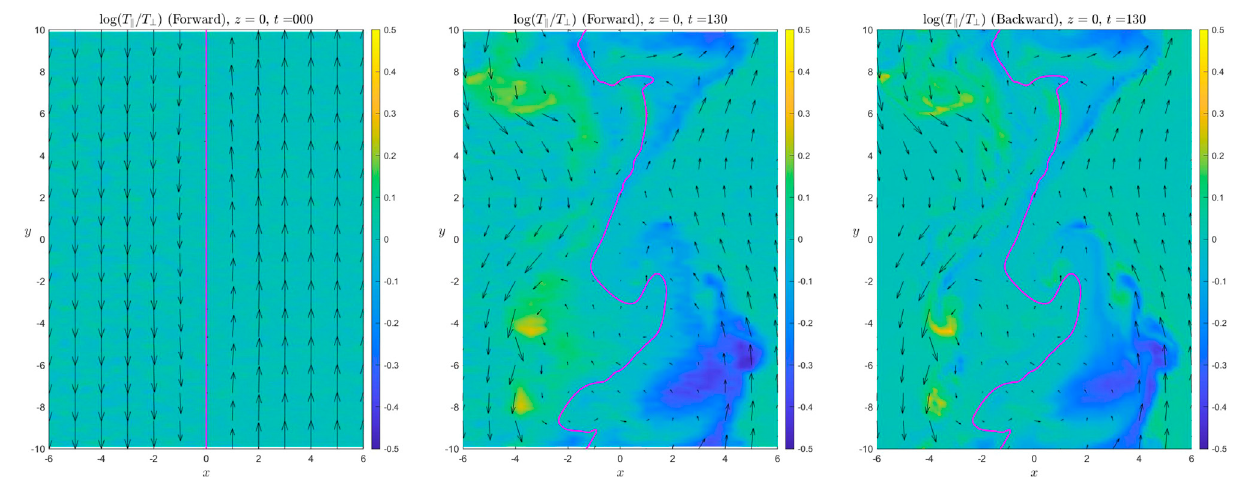
FIGURE 5 | The color index represents the temperature anisotropy T (cid:3) / T ⊥ at t (cid:1) 0 (left) t (cid:1) 130 (middle) for the symmetric case by using forward tracing method. The right panel shows the results from backward tracing method. The black arrows represent the x and y components of the bulk velocity from MHD simulation. The magenta line represents the magnetosheath-magnetosphere boundary based on magnetic fi eld topology.